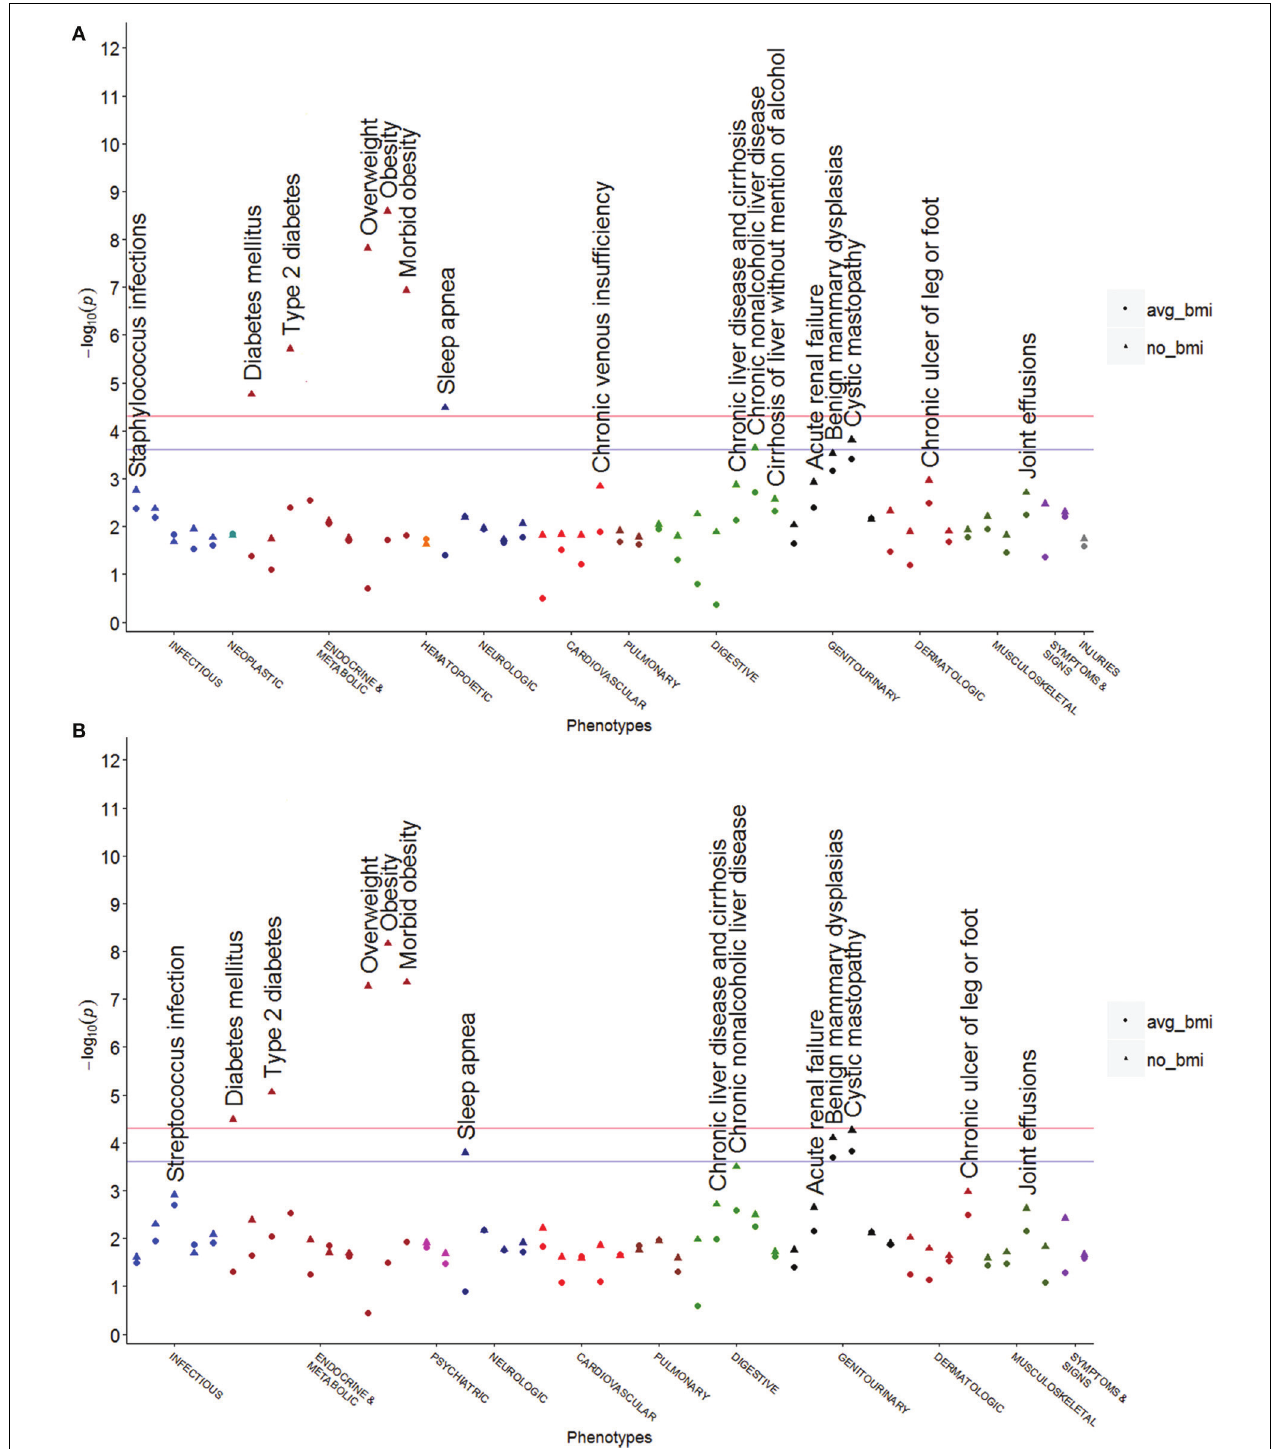
horizontal line represents an FDR q = 0 . 05 ( p = 2 . 48 × 10 − 4 ). (A) rs9939609 is reported widely in the literature and has a nearly identical pattern of associations to rs8050136 ( r 2 = 0 . 96). (B) rs9941349 also has a similar pattern to rs8050136 but cystic mastopathy is marginally more associated ( p = 5 . 41 × 10 − 5 , OR = 0 . 81 before BMI adjustment) than in rs8050136 ( r 2 = 0 .